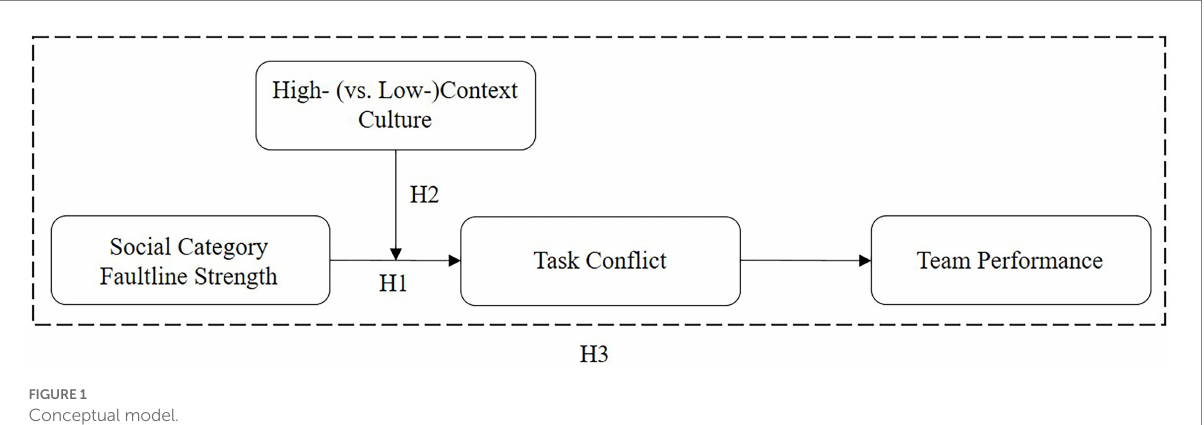
FIGURE 1 Conceptual